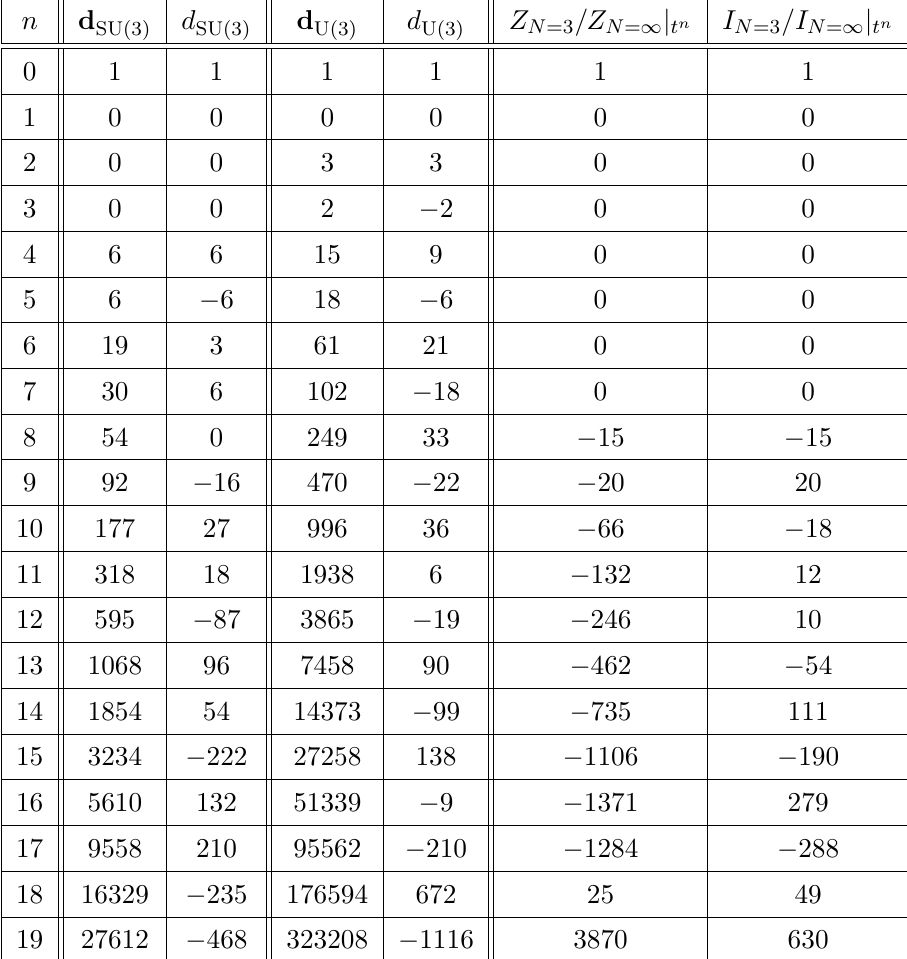
Table 4 . Counting of 1/16-BPS states for SU(3) and U(3) gauge groups, and the coefficients of Z N =3 /Z N = ∞ and I N =3 /I N = ∞